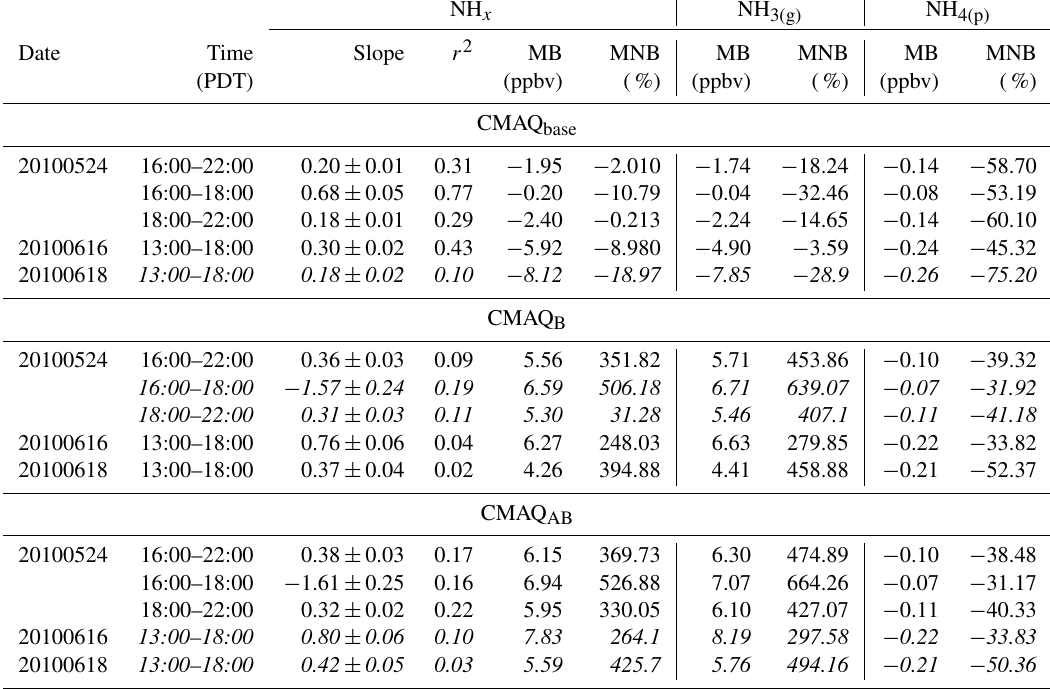
Table 2. Summary statistics of the modeled to measured NH x concentration comparisons following the SJV flights. Mean bias (MB) = mean (modeled–measured); mean normalized bias (MNB) = mean ([modeled–measured]/measured). Note that low r 2 values, less than 0.10, are highlighted in